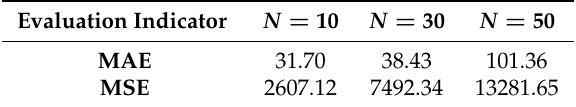
Table 7. Prediction accuracy with different prediction steps.